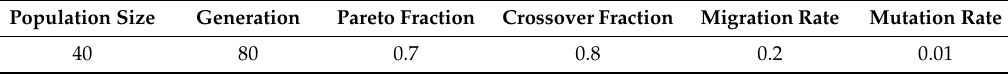
Table A2. Numerical parameters of optimization algorithm.